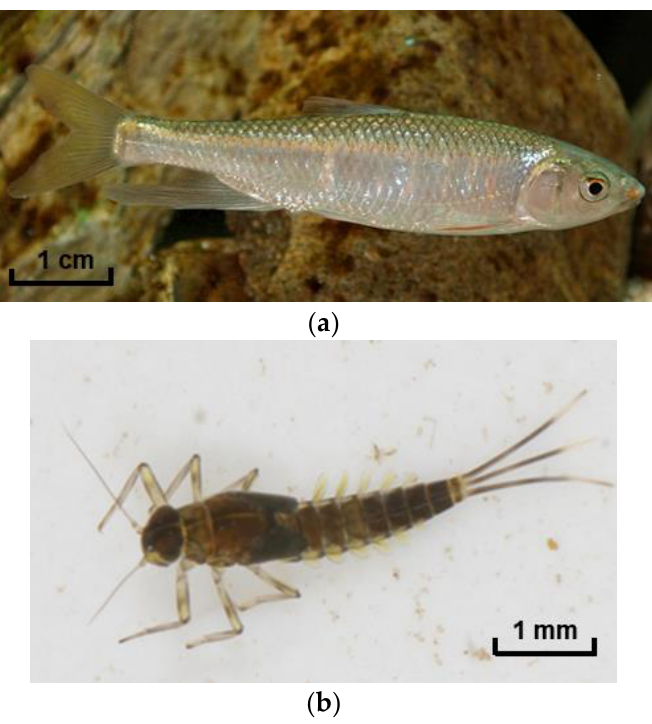
Figure 2. The target Fish and benthic macroinvertebrate: ( a ) Zacco platypus and ( b ) Baetis fuscatus .